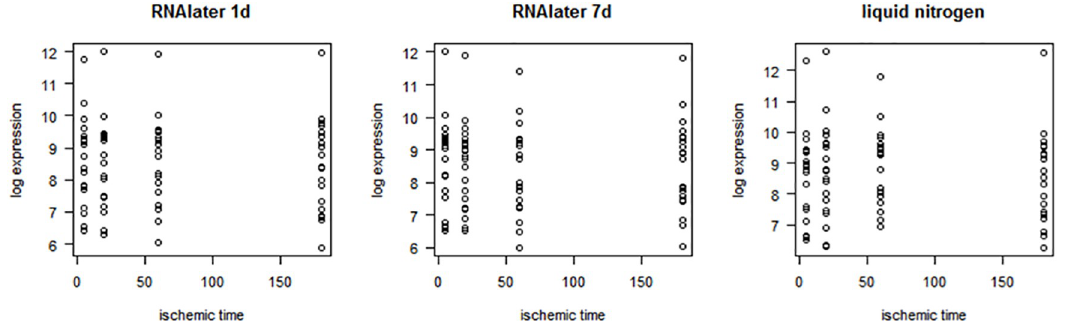
Fig 5. Scatterblots of mRNA expression values. Samples were processed in RNAlater (1 or 7 days) or by snap freezing in liquid nitrogen. Assuming a log-normal distribution of expression values, all computations were performed on a log scale.